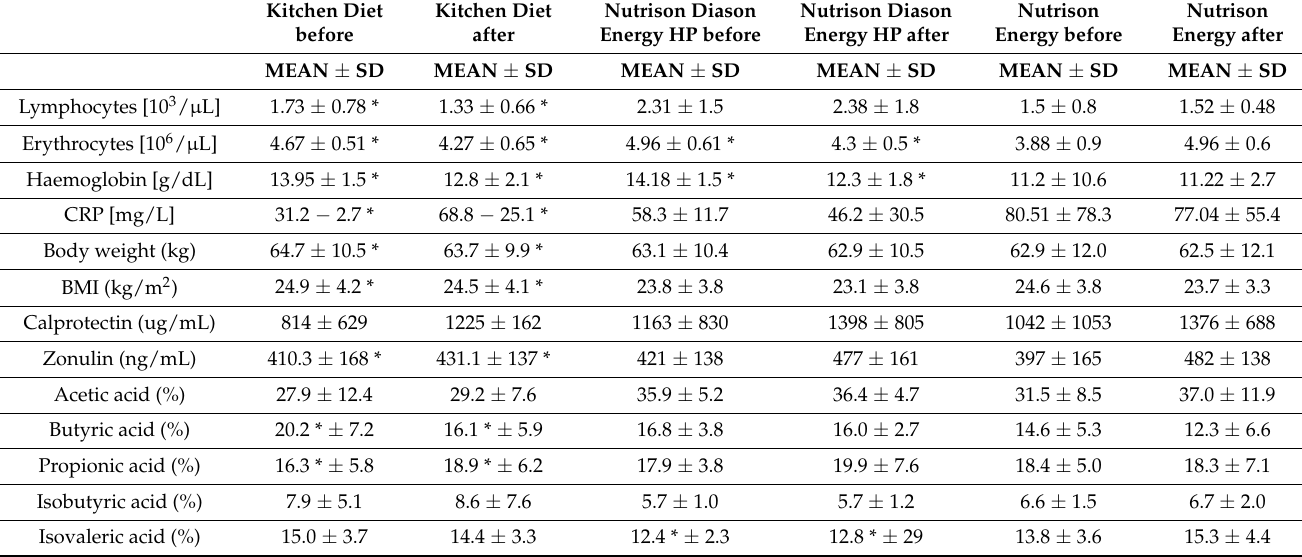
Table 3. Anthropometric and gut barrier parameters (short and branched fatty acids, zonulin, calprotectin) in studied groups by diet type and time of analysis (mean ±